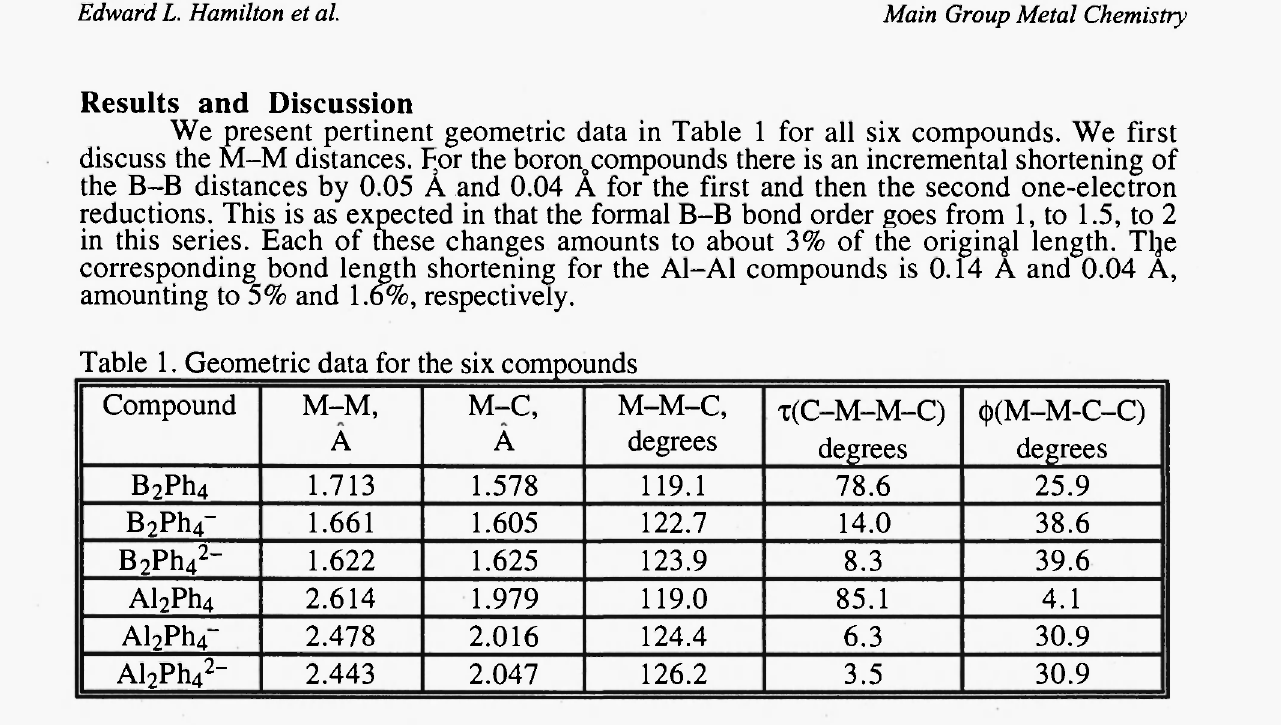
Table 1. Geometric data for the six